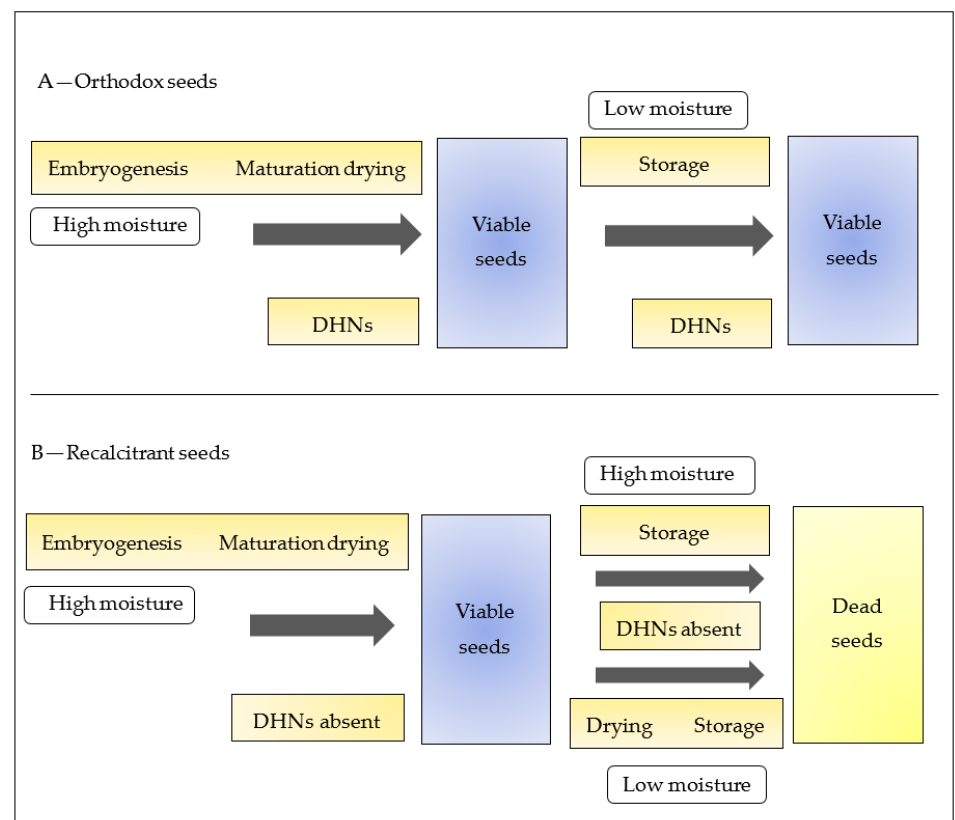
Figure 2. DHN expression during maturation drying ( A —orthodox seeds, B —recalcitrant seeds). ( A ) Orthodox seeds synthesize DHNs as a response to maturation drying and to storage under low moisture conditions and retain their viability after seed storage. ( B ) Recalcitrant seeds lack DHNs during maturation drying and storage under low and high moisture conditions; therefore, they become unviable after drying and seed storage.